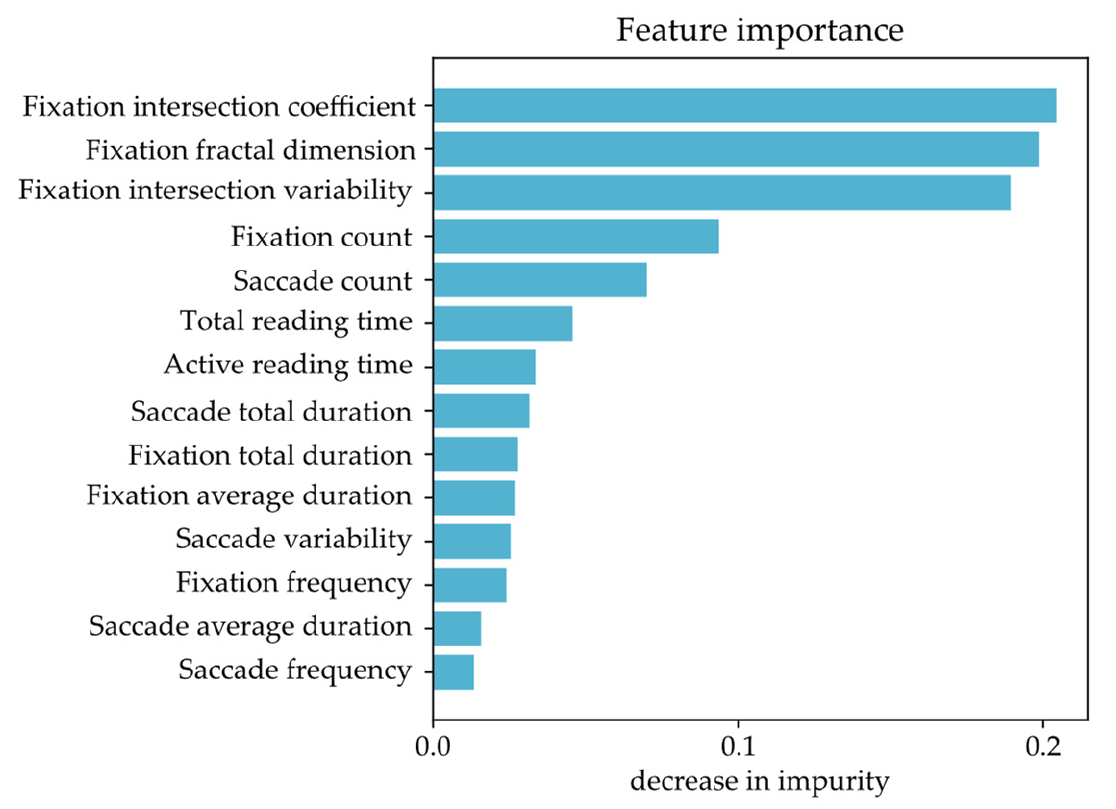
Figure 3. Feature importance of the eye-tracking features based on the decrease in the impurity of the random forest algorithm.